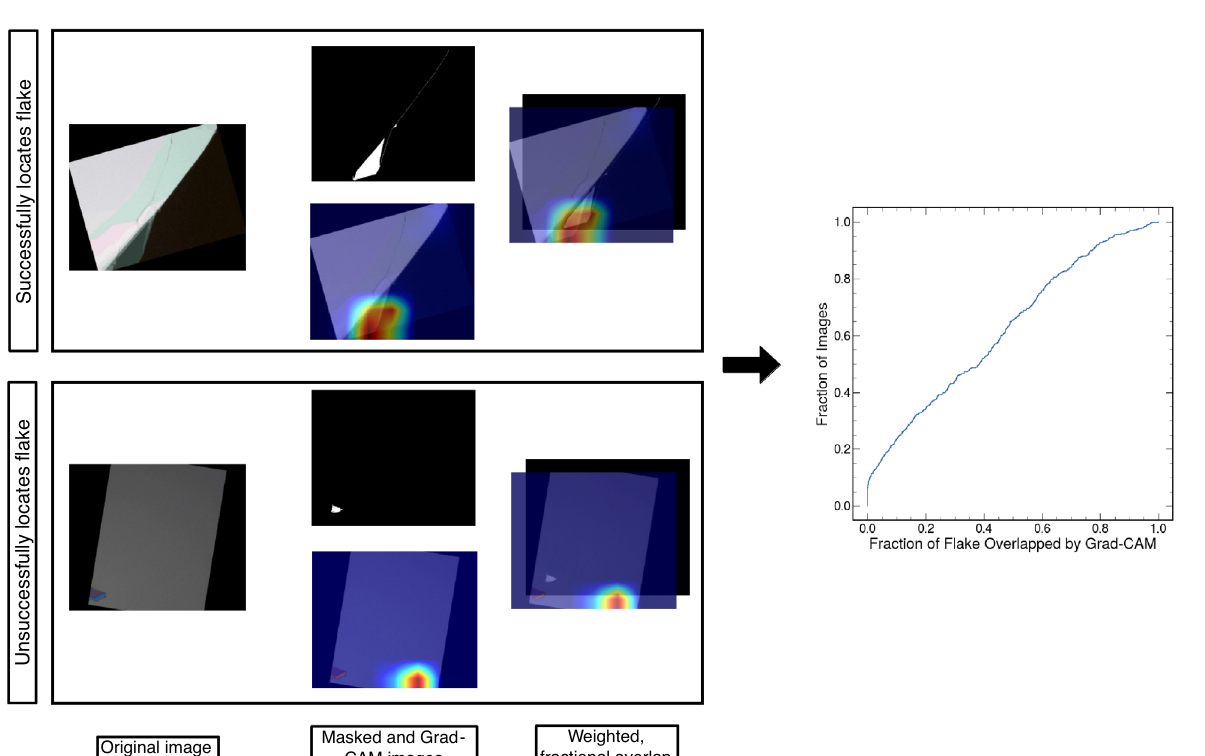
Figure 3. Grad-CAM Evaluation with an Empirical Cumulative Distribution Function. For 500 correctly classified flake images quantized with 20 colors, the weighted fraction of flake highlighted by the Grad- CAM heatmap is displayed as an empirical cumulative distribution function (on the right). The process for determining the fractional overlap for an unsuccessful image (overlap < 0.1) and a successful image (overlap > 0.9) are shown. In both instances, a masking algorithm locates the thin flake and determines the weighted fraction of overlap between this flake and the Grad-CAM